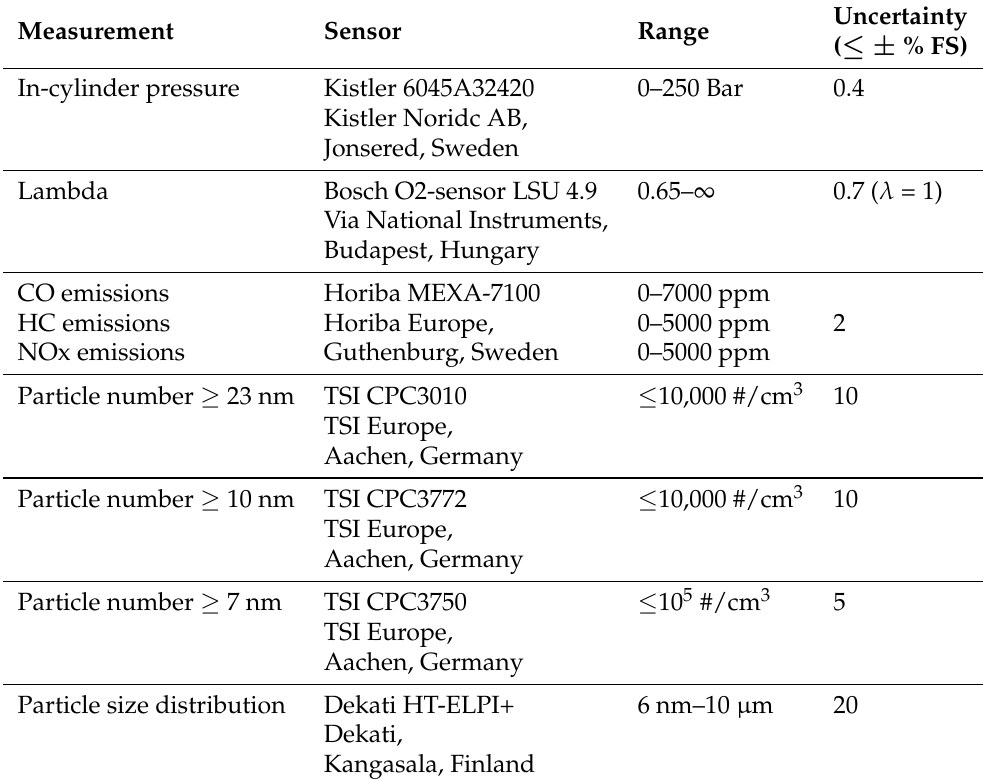
Table 3. Sensor measurement range and